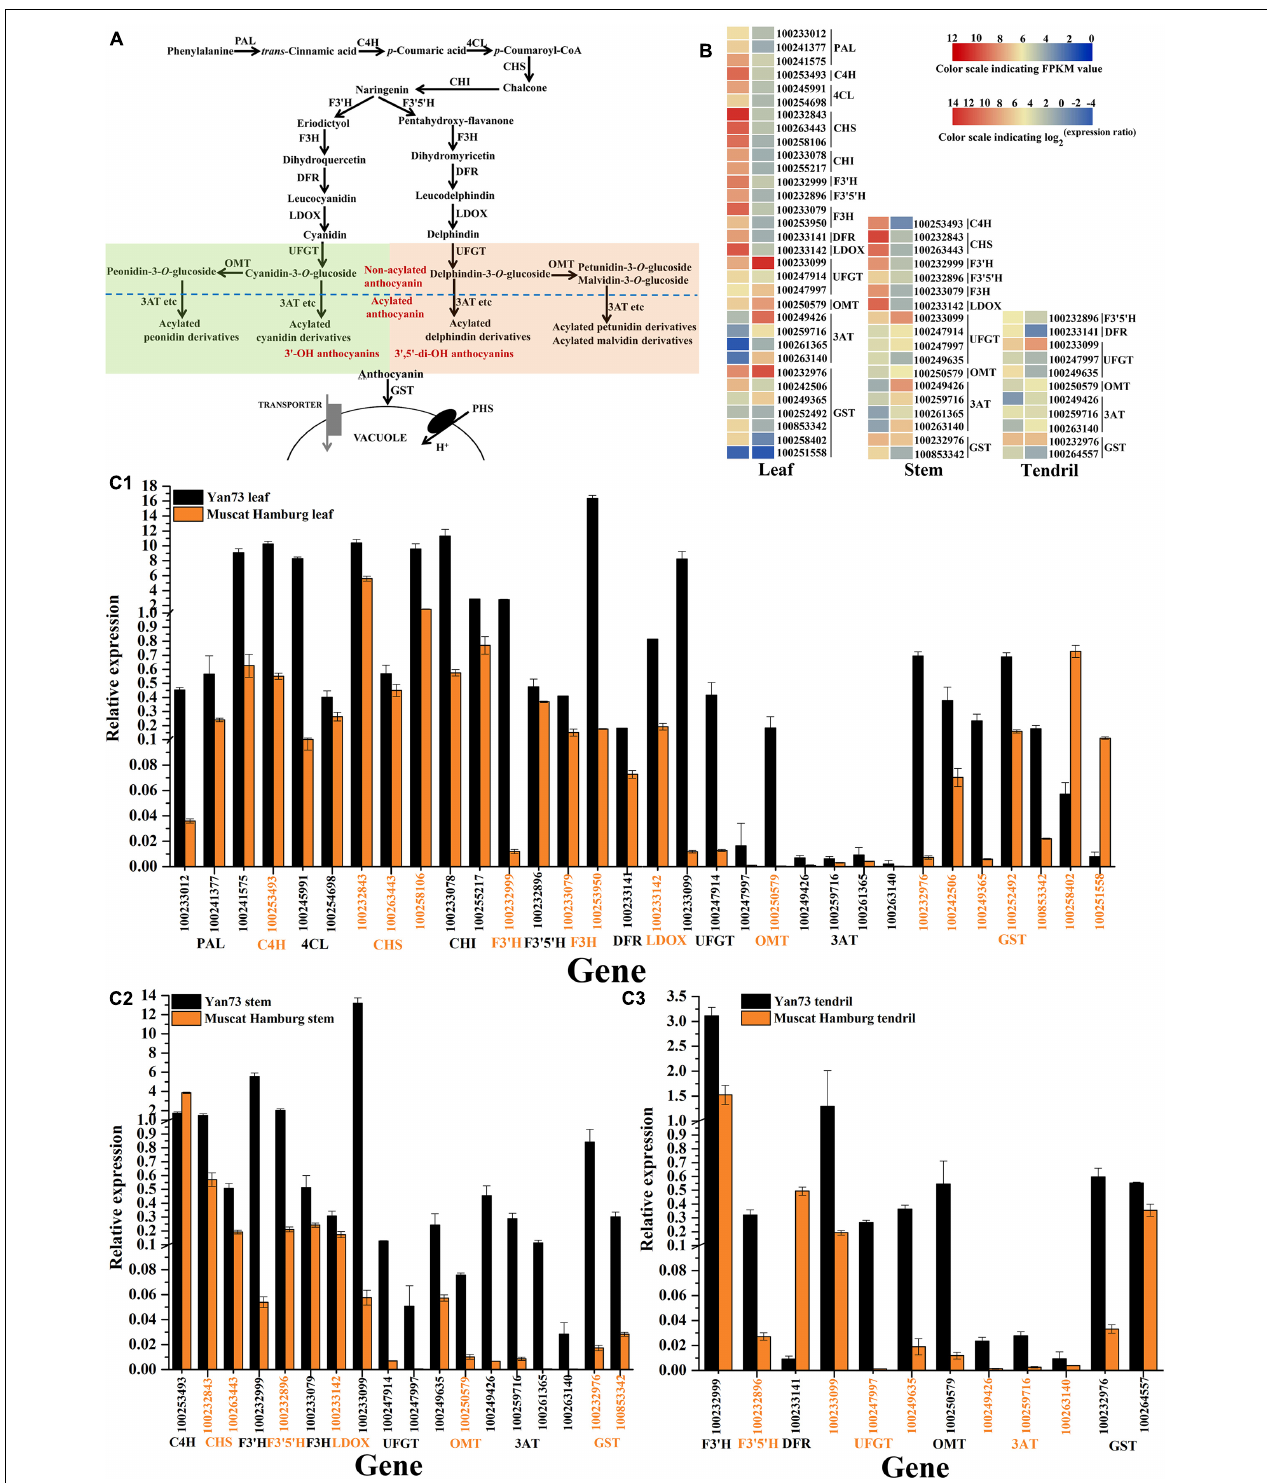
FIGURE 3 | Expression analysis of anthocyanin biosynthesis genes in Yan73 and its male parent (Muscat Hamburg) leaf, stem and tendril tissues. (A) Schematic of anthocyanin biosynthesis pathways in grapevine vegetative tissues. PAL, phenylalanine ammonia lyase; C4H, trans -cinnamate 4-monooxygenase; 4CL, 4-coumarate: CoA ligase; CHS, chalcone synthase; CHI, chalcone isomerase; F3 (cid:48) H, flavonoid 3 (cid:48) -hydroxylase; F3 (cid:48) 5 (cid:48) H, flavonoid 3 (cid:48) ,5 (cid:48) -hydroxylase; F3H, flavanone 3-hydroxylase; DFR, dihydroflavonol 4-reductase; LDOX, leucoanthocyanidin dioxygenase; UFGT, anthocyanidin 3- O -glucosyltransferase; OMT,